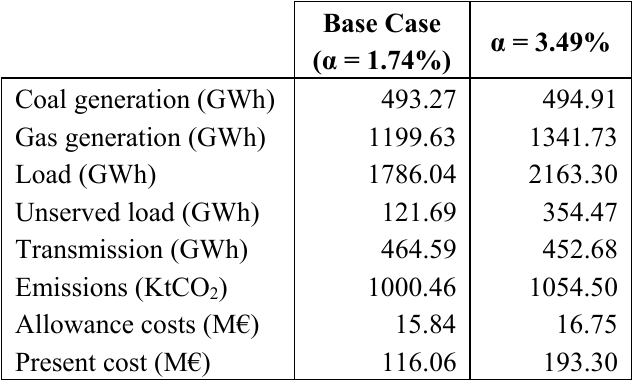
Table 6. Average generation, load, transmission, and costs ( 1 L ): Base case vs. higher load